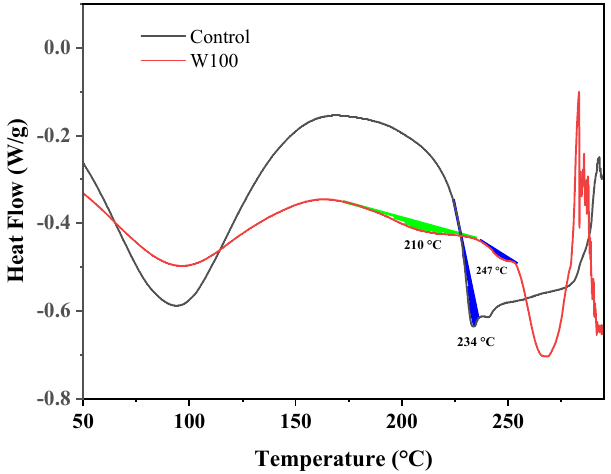
Figure 8. DSC curves of the control and PBTCA − treated wool.